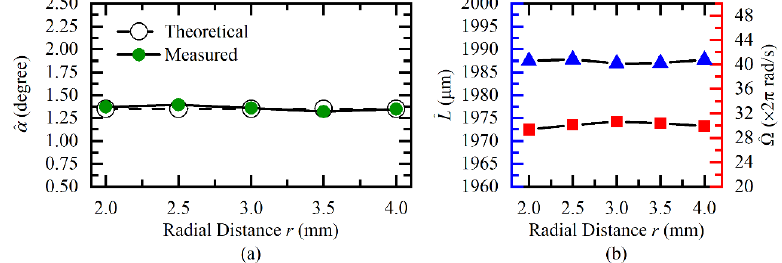
Figure 9. Measurement results of ( a ) tilt angle, ( b ) axial clearance, and angular velocity under different radii.